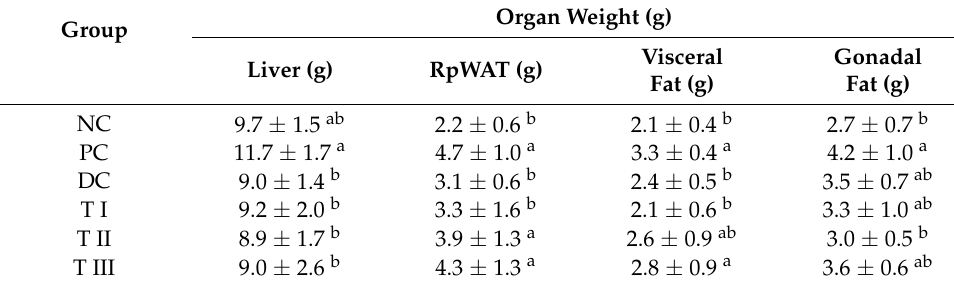
Table 2. Anti-obesity effect of E. tapos shell extract on organ weight.